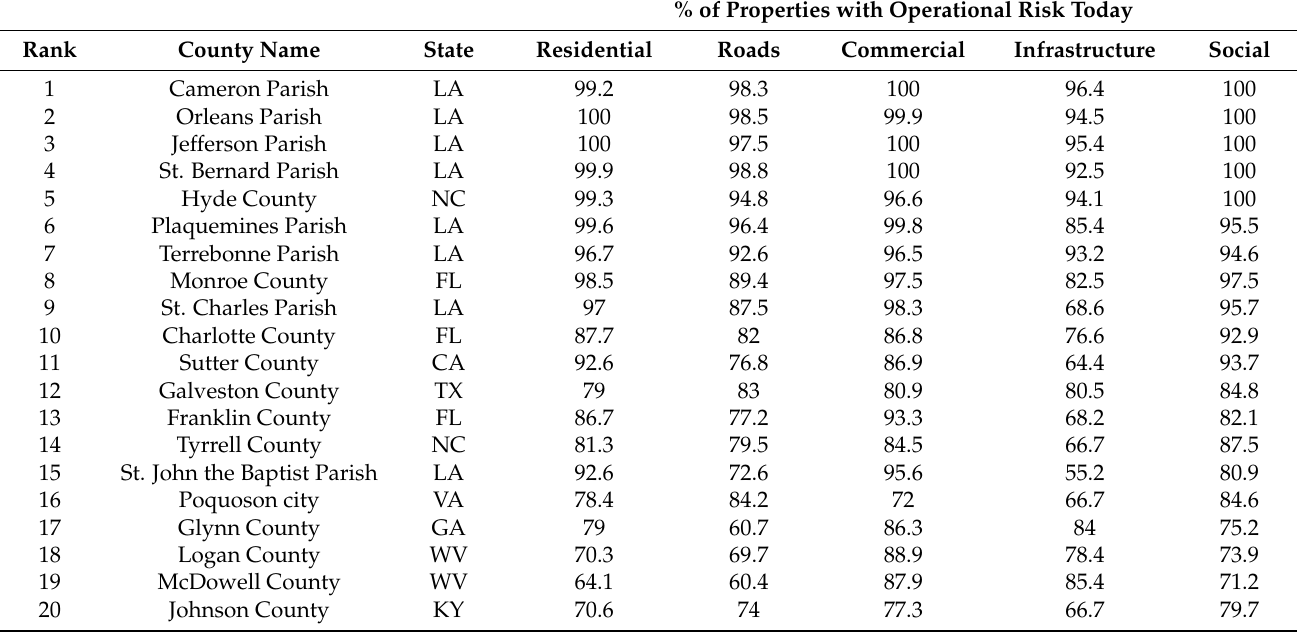
Table 3. Top 20 “most at risk” counties in the U.S. % of Properties with Operational Risk Today